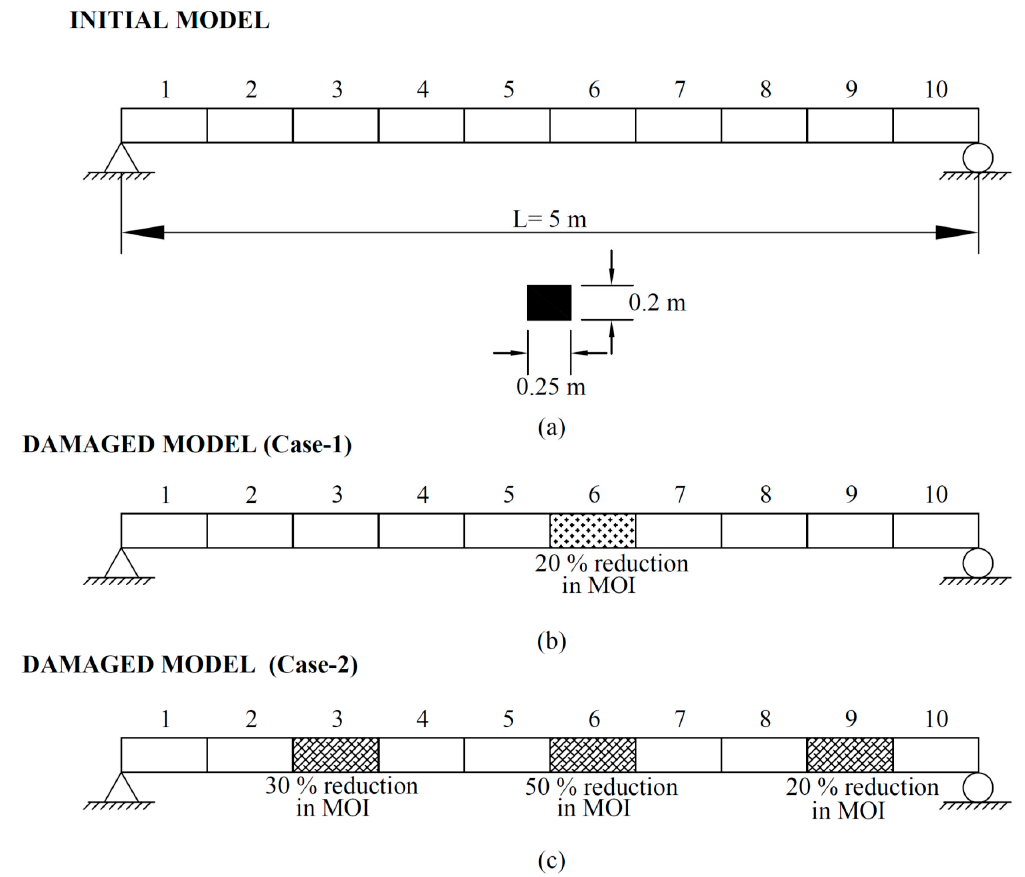
Figure 1. ( a ) Simulated healthy beam. ( b ) Damaged model (Case 1) withsingle damage scenario. ( c ) Damaged model (Case 2) with multiple damage scenario. MOI, moment of inertia.